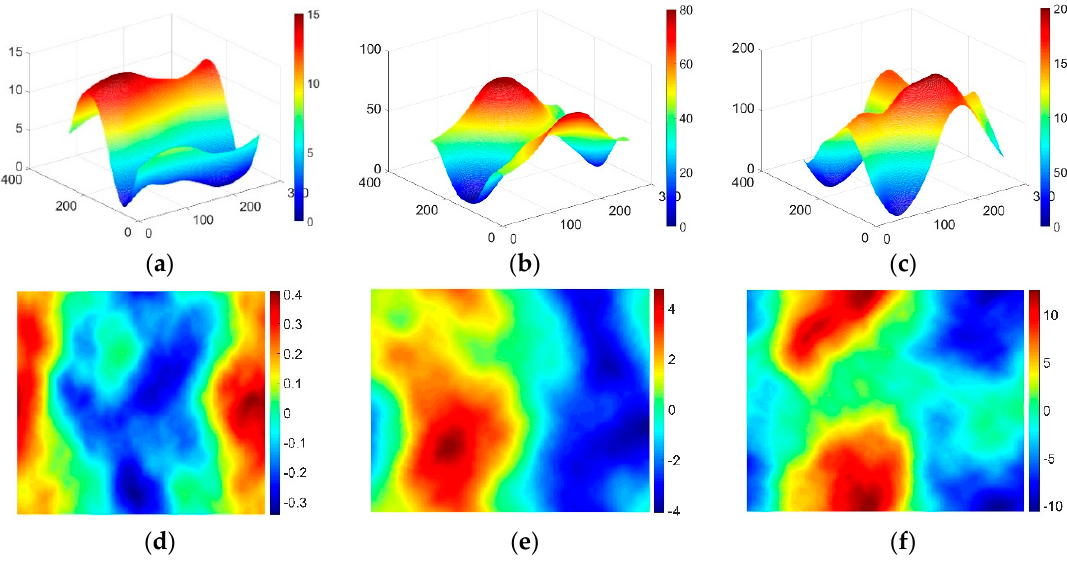
Figure 7. Simulated DEMs and terrain slope maps. ( a ), ( b ) and ( c ) Three different irregular DEMs (unit = meters); ( d ), ( e ) and ( f ) terrain slope maps corresponding to ( a ), ( b ) and ( c ), respectively (unit = degrees).